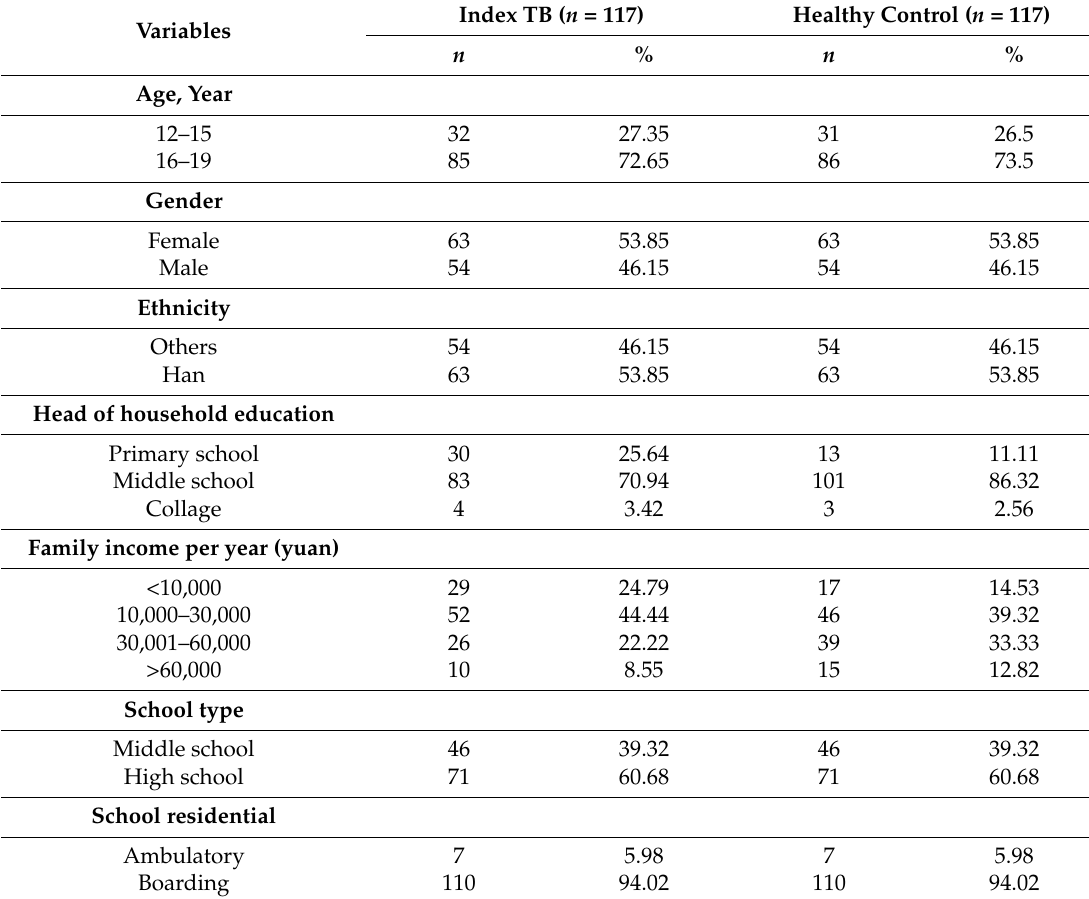
Table 1. Characteristics of adolescent index tuberculosis (TB) case and healthy